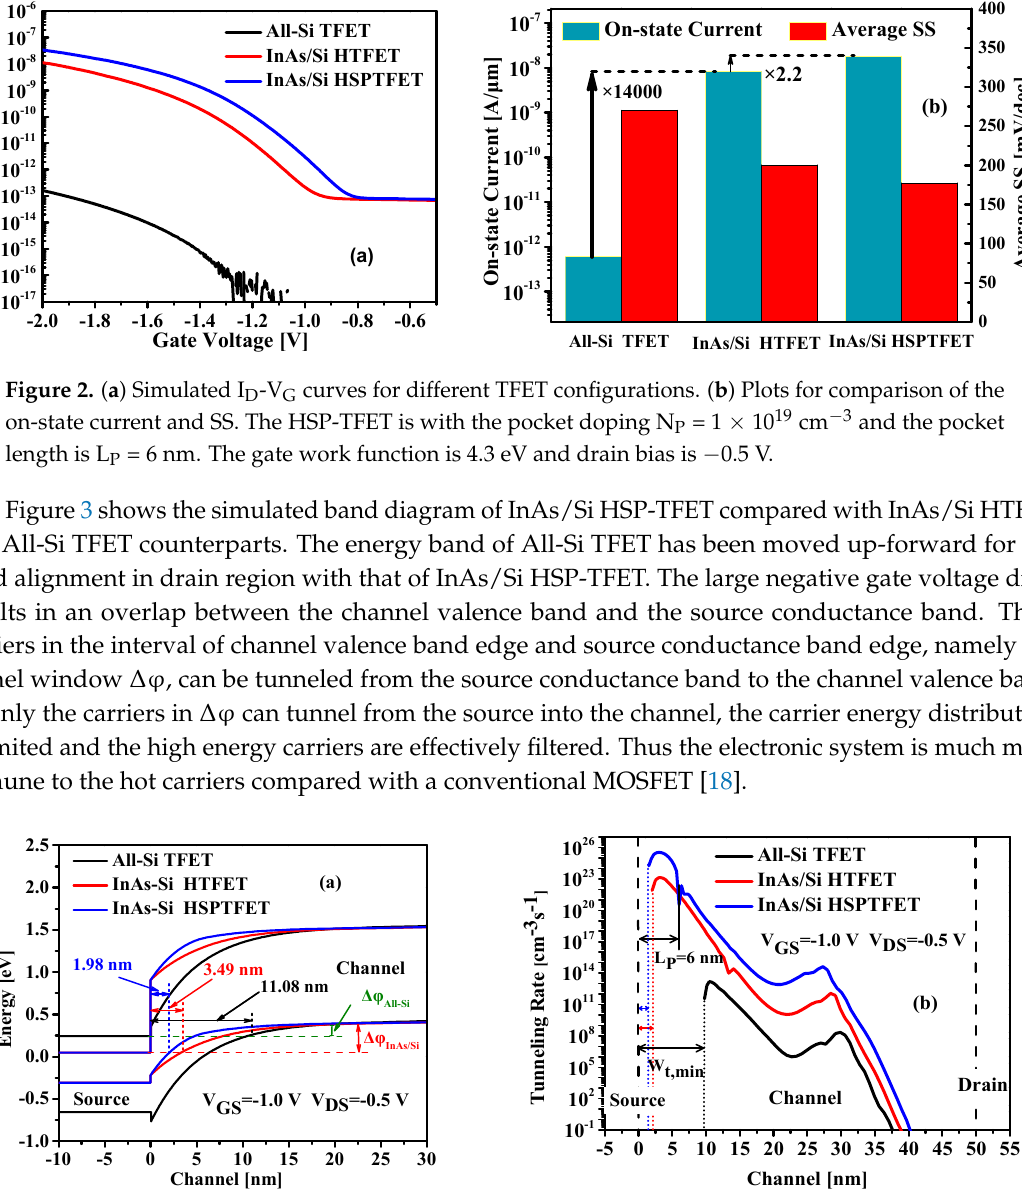
Figure 3. ( a ) Illustration of the energy band diagrams and ( b ) carrier band to band tunneling rate profile along the channel/oxide interface.